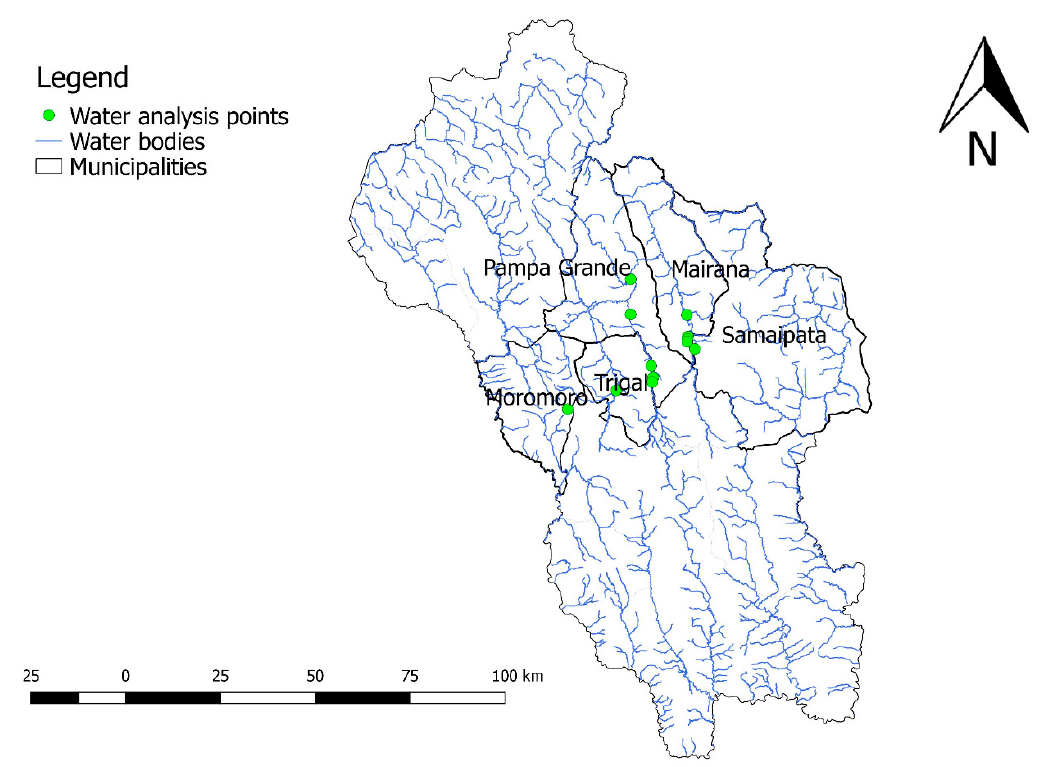
Figure 3. Abstraction points for water samples, “Valles Cruceños” region, Bolivia, 2019.